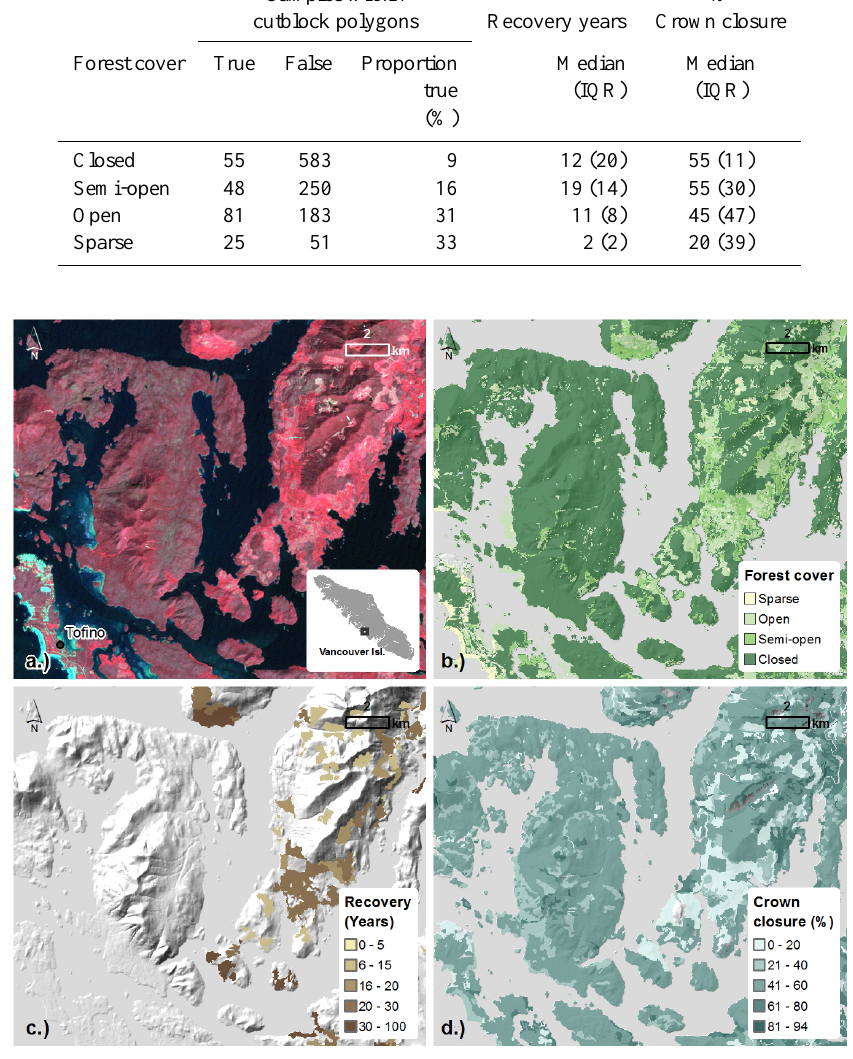
Figure 5. A false-colour composite highlighting forests around Tofino, Vancouver Island, from Landsat TM imagery (a) and the correspond- ing result from the forest cover classification (b) . A BC forest cutblock inventory showing the recovery period relative to 2006 (c) . Crown closure (%) from the VRI data set (d)